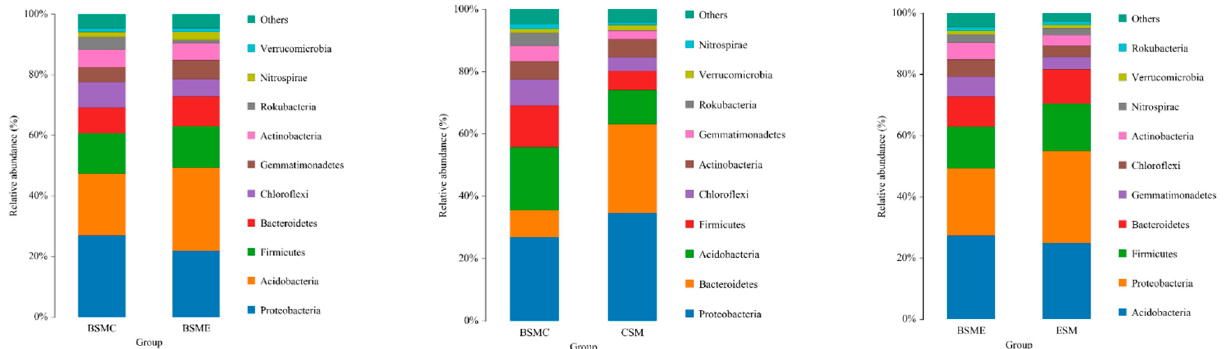
Figure 5. Histogram of relative abundance of horizontal species of the phylum. BSMC: soil microorganisms in the counterpart group before the experiment; BSME: soil microorganisms in the experimental group before the experiment; CSM: soil microorganisms in the counterpart group after the experiment; ESM: soil microorganisms in the experimental group after the experiment.